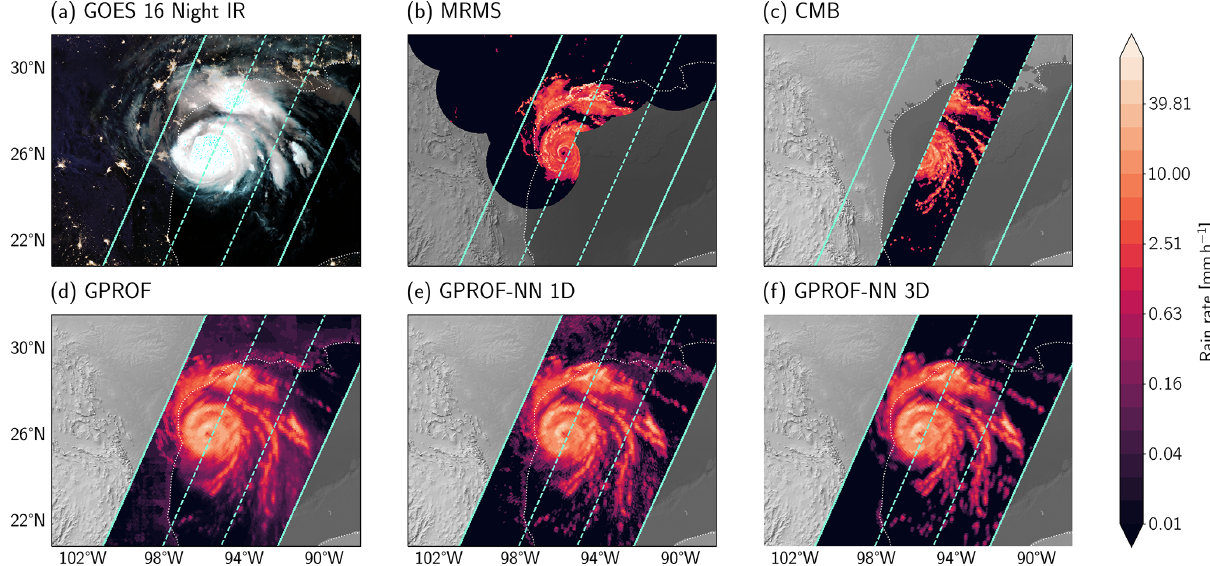
Figure 12. Surface precipitation during Hurricane Harvey on 25 August 2017 at 11:50:00UTC retrieved from GMI. Panel (a) shows a GOES 16 Night IR composite (generated using the night_ir_with_background_hires composite in satpy, Raspaud et al., 2021), which merges infrared observations from the Advanced Baseline Imager (ABI, Schmit et al., 2005) on GOES 16 and NASA black marble imagery (NASA, 2022). Panel (b) shows ground-based precipitation measurements from MRMS for which the radar quality index exceeds 0.8. Panel (c) shows retrieved surface precipitation from the CMB product. Panels (d) , (e) , and (f) show the retrieved surface precipitation